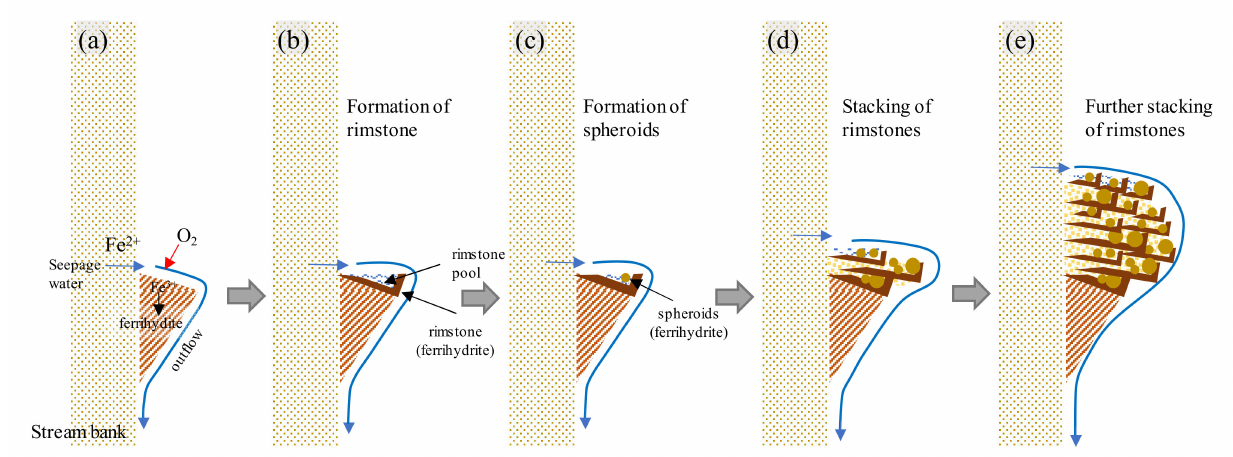
Figure 7. Illustration of formation of aggregate by stacking connected rimstones made of ferrihydrite. ( a ) Seepage waters flow out from the stream bank, ferrous iron in outflow water reacts with atmospheric oxygen to form ferrihydrite, which appears as flowstone on the stream bank. ( b , c ) Rimstones and rimstone pools are formed, along with formation of spheroids. ( d ) Rimstones are connected to each other and build up upward, along with flattening of the basins. Outflow position rises during growing rimstone systems. ( e ) Formation of connected rimstones and filling of their pools are repeated, resulting in a wasp-nest shaped